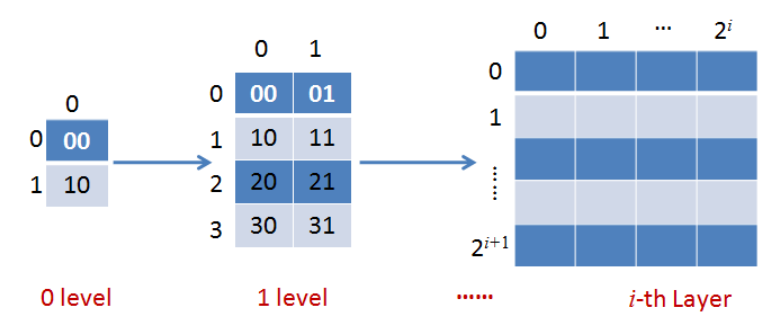
Figure 2. The image tiles coding